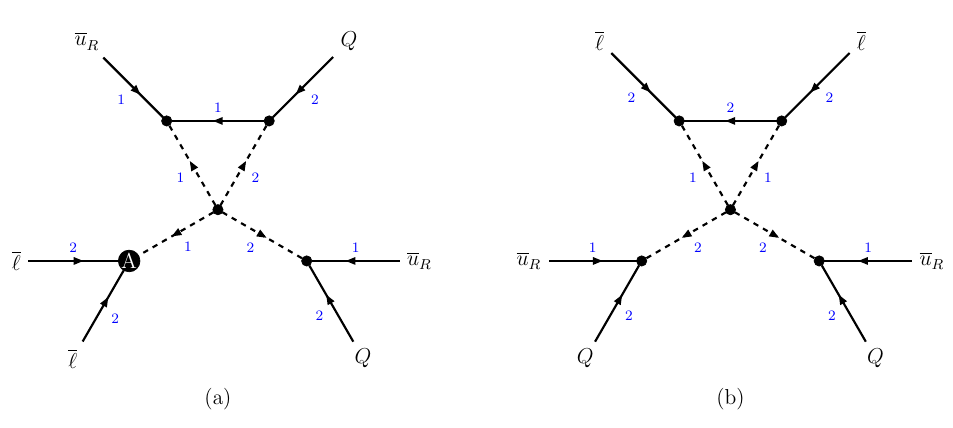
Figure 5 . Both models shown in panels (a) and (b) fulfill the SU(2) L invariance, where the numbers 1 and 2 denote the SU(2) transformations of the fields. For the diagram (a), there is a vanishing point interaction ¯ ‘‘ c S at the vertex A . The model in panel (b) doesn’t contribute to the 0 νββ